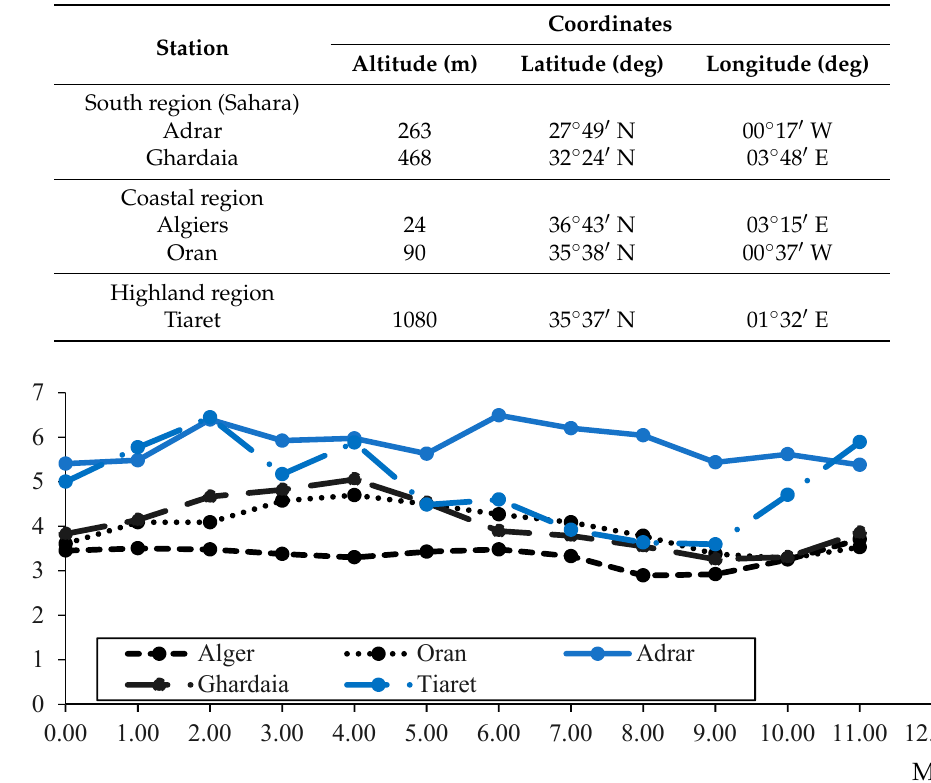
Figure 3. Wind speed variations at different locations in Algeria.